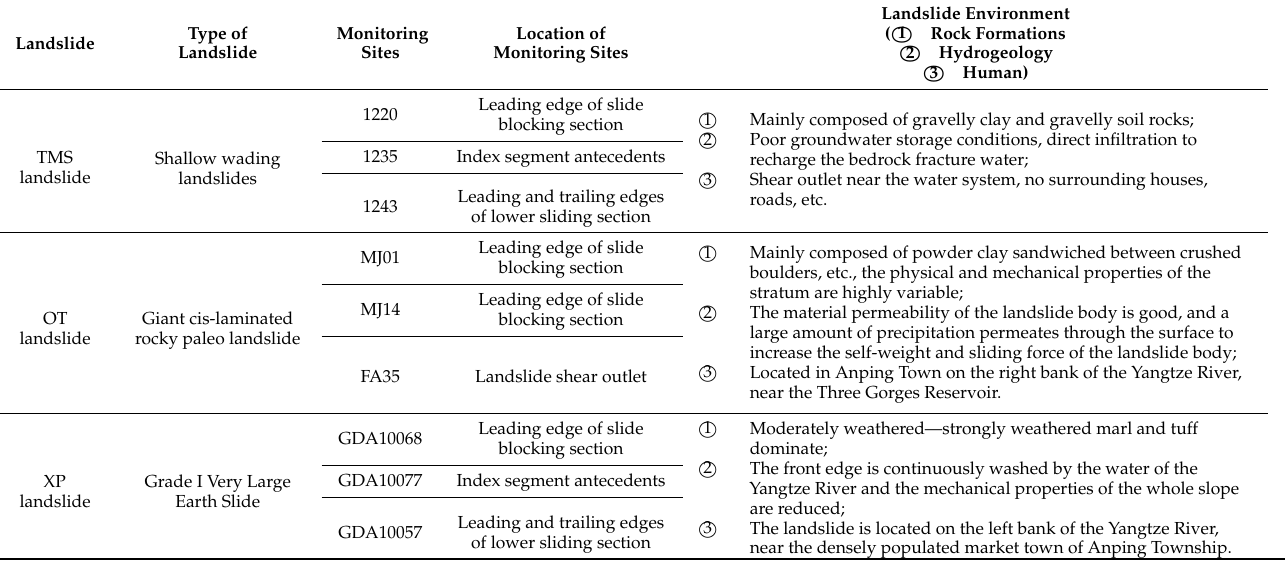
Table 1. A qualitative description of the landslide area and monitoring points in the study (partly collected from the literature) will be used for the quantitative analysis in this paper.